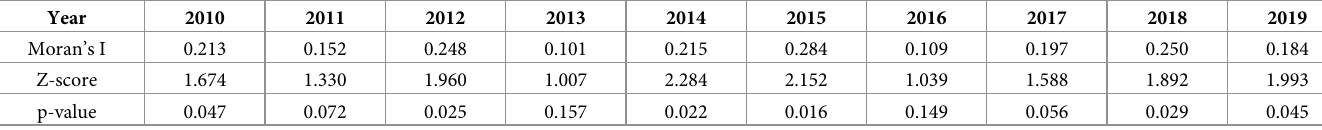
Table 3. Global Moran’s indexes of culture and tourism integration efficiency in Shandong